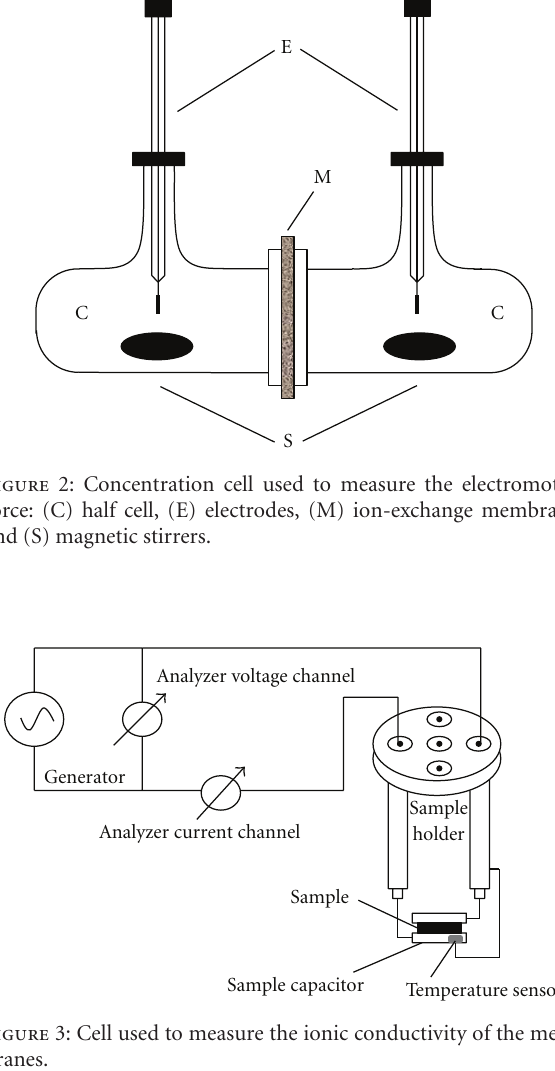
Figure 5: Evolution of the emf of the C5FNDIHS membrane for di ff erent c 2 /c 1 ratios: ( (cid:2) ) 0.01/0.005, ( • ) 0.02/0.01, ( (cid:6) ) 0.1/0.05, ( (cid:3) ) 0.2/0.1, ( (cid:2) ) 0.4/0.2, ( (cid:4) ) 0.8/0.4, and ( ♦ )